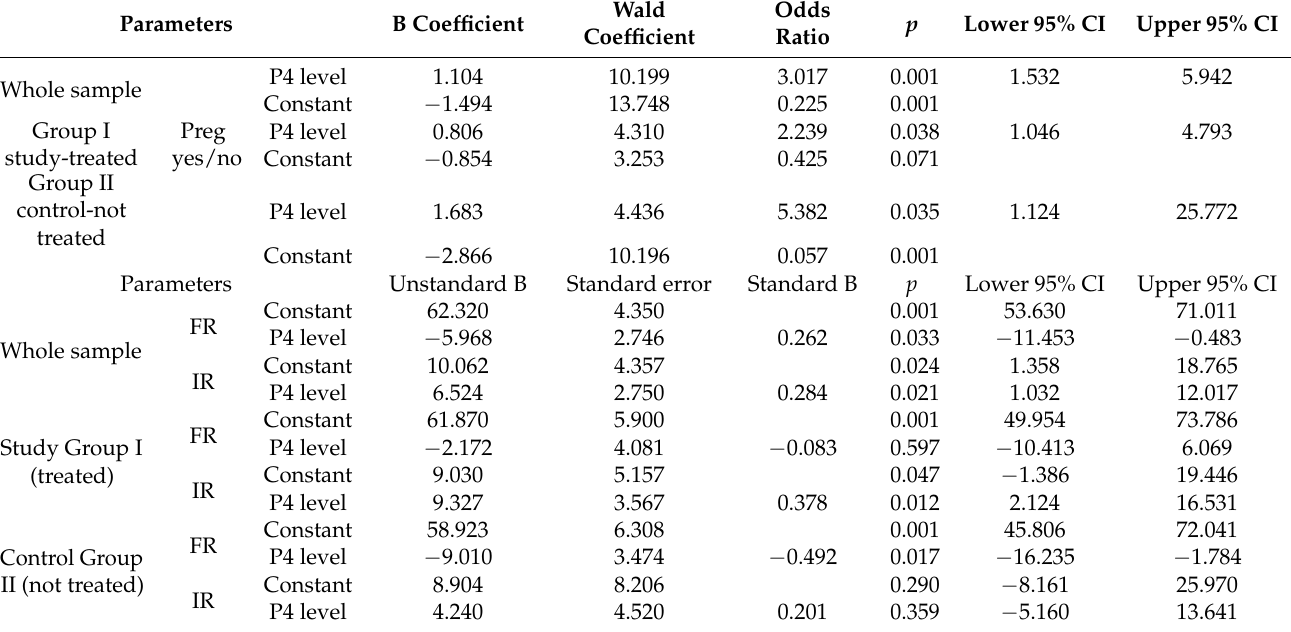
Table 3. Unadjusted models of the relationship between the P4 levels and pregnancy